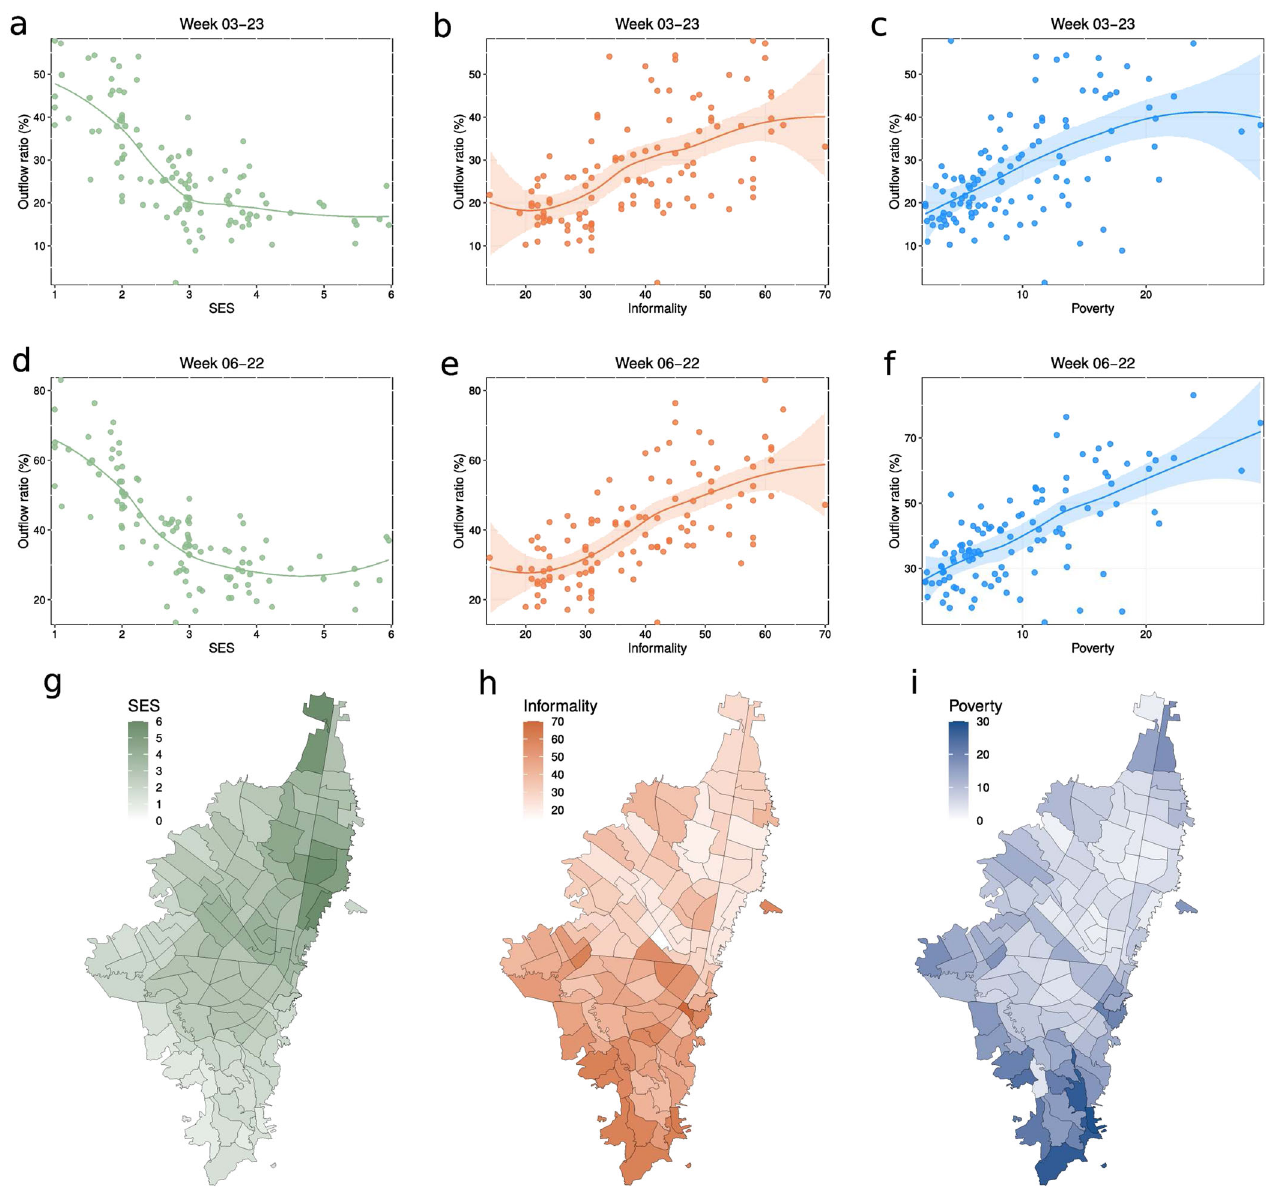
Fig. 3 Changes in mobility and socioeconomic conditions. a – f Correlations between out fl ows ratio at the UPZ level with respect to the reference week (February 3) and socioeconomic strata (SES), the share of informal workers, and multidimensional poverty, respectively. g – i Socioeconomic conditions at the UPZ level. Maps exclude rural